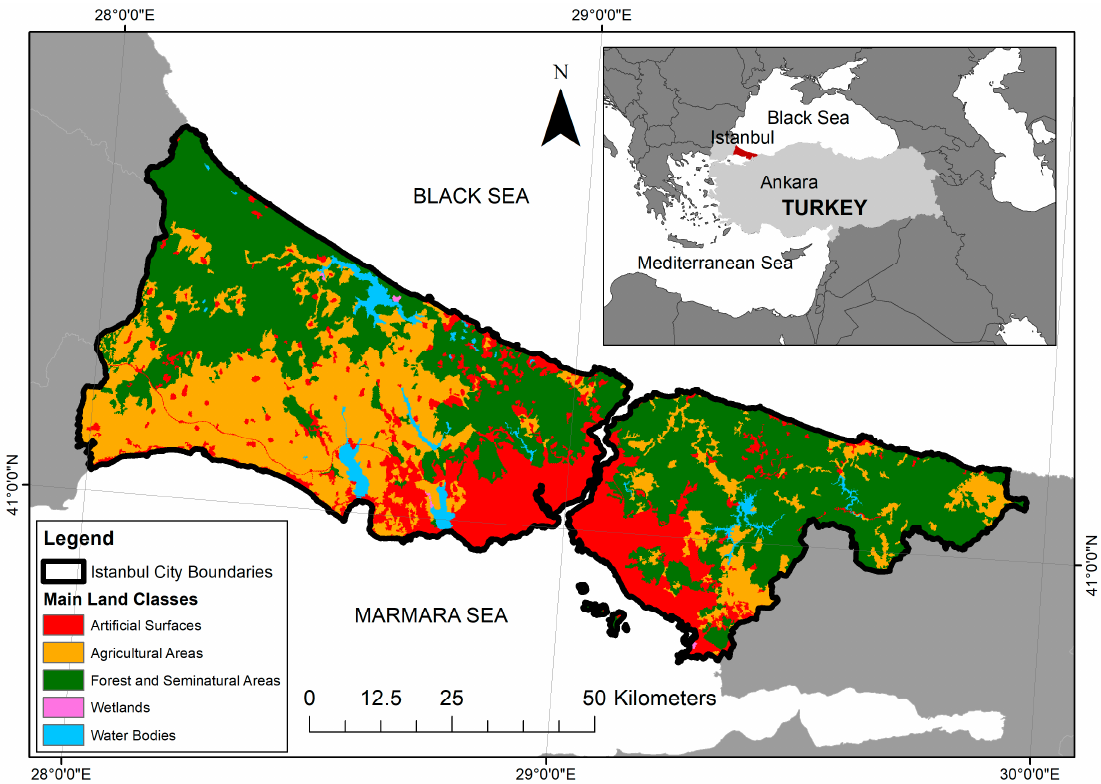
Figure 1. Istanbul city boundary and main land cover classes.